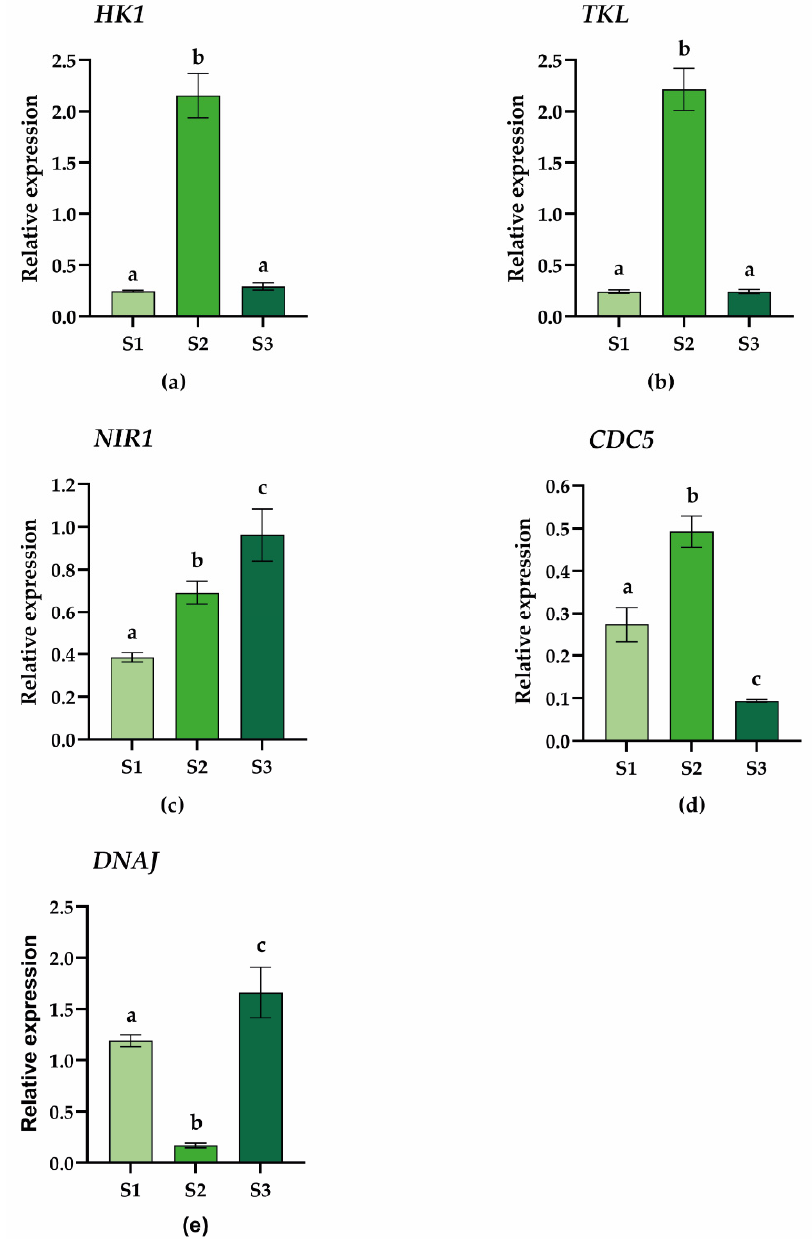
Figure 7. Relative expression of C. quitensis genes normalized with the reference genes elongation factor 1-alpha ( EF1 α ). ( a ) Hexokinase ( HK1 ); ( b ) transketolase ( TKL ); ( c ) nitrite reductase 1 ( NIR1 ); ( d ) cell division cycle 5 ( CDC5 ); ( e ) DNAJ . Error bars represent the mean ± SD of three biological replicates. Statistic test: one-way ANOVA, Tukey’s multiple comparisons ( p < 0.05). The letters indicate significant differences between the samples.